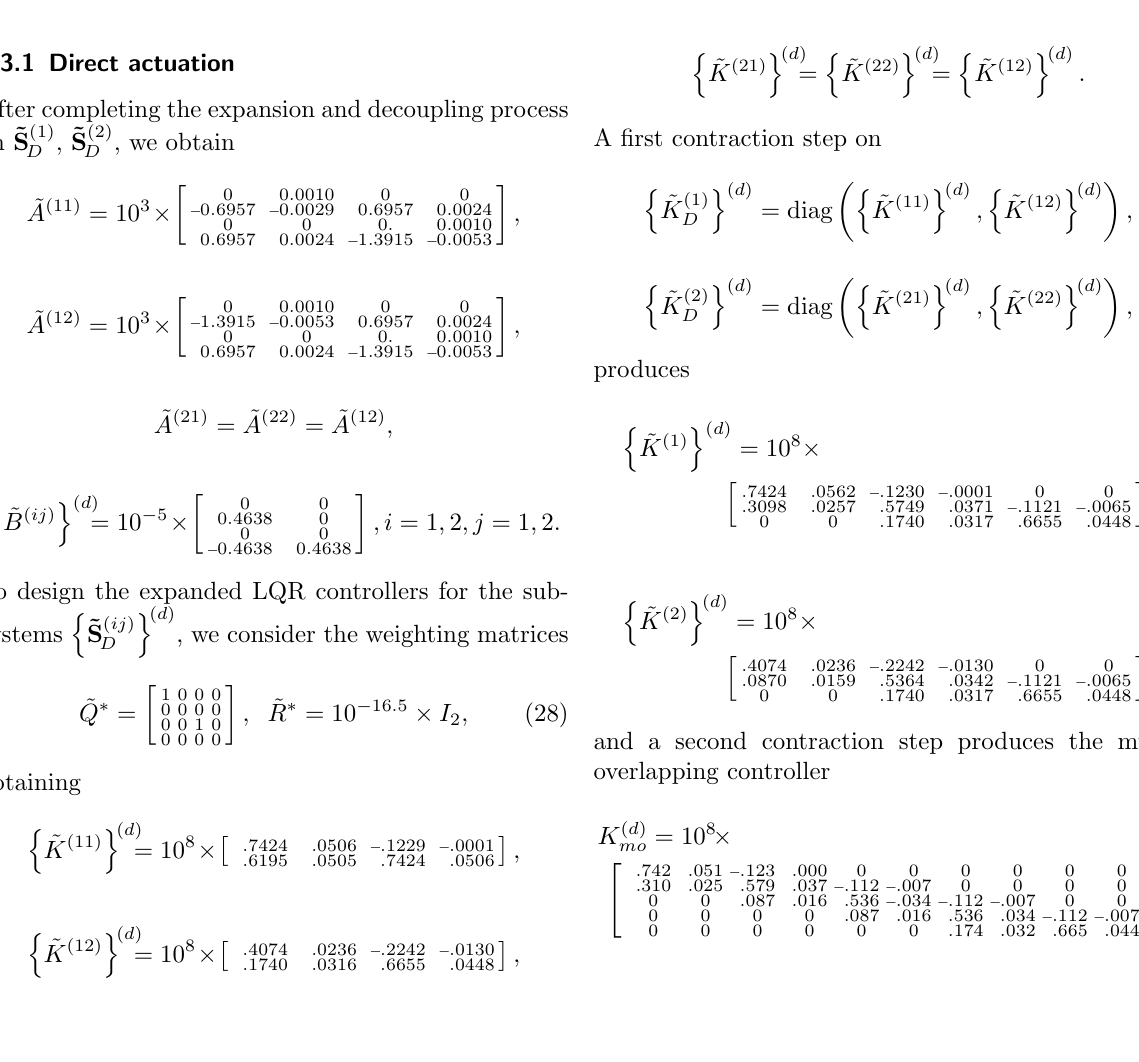
Figure 8: Multi-overlapping expansion-contraction